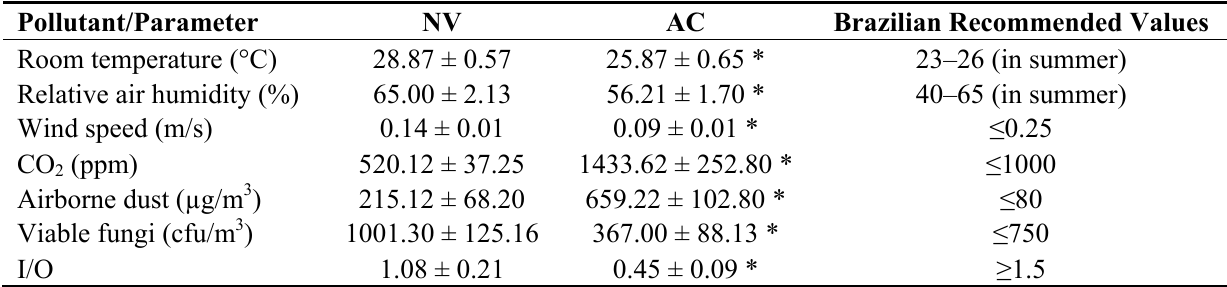
Table 2. Indoor environmental quality parameters evaluated in